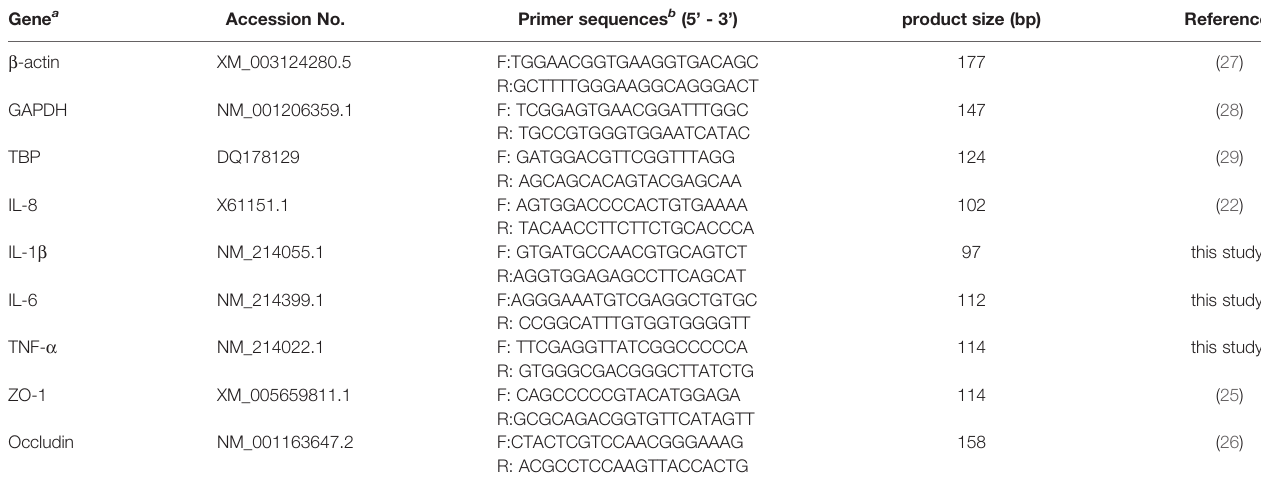
TABLE 1 | Primers for genes quanti fi ed with real-time PCR in the current study. Gene a Accession No. Primer sequences b (5 ’ - 3 ’